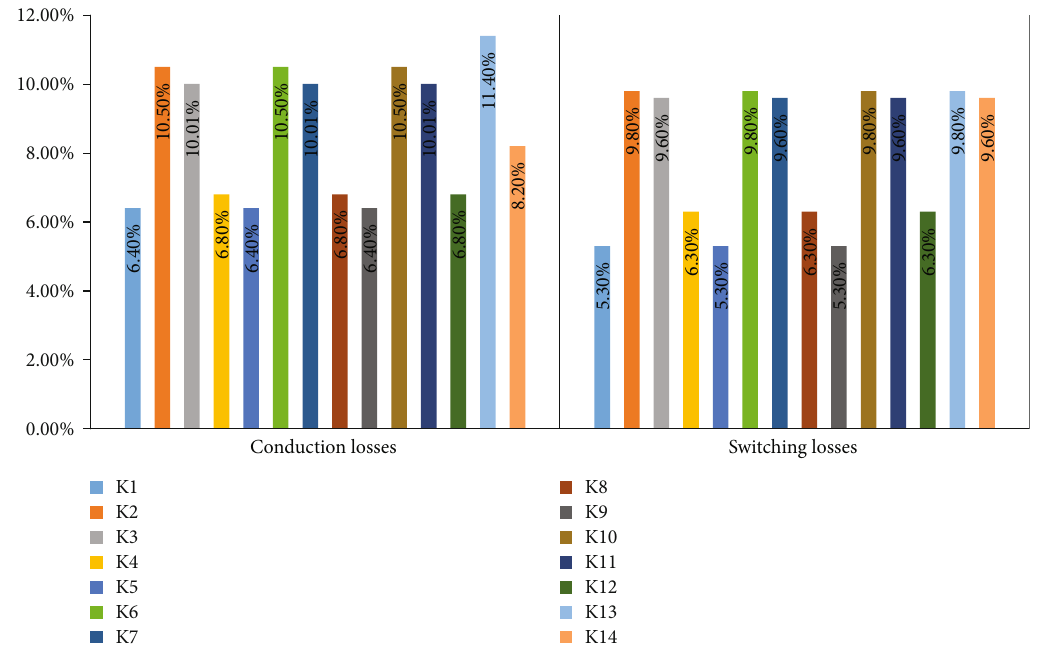
Figure 14: Power loss distribution in each switch of the 5 L-SMC H-bridge inverter. Table 5: Comparison of the results obtained with the literature. Controls THD V